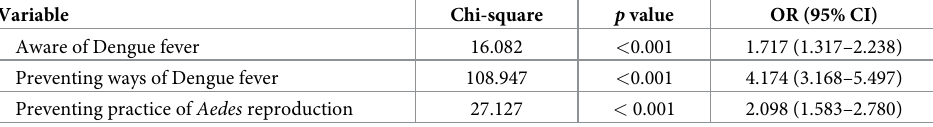
Table 6. Association between aware (Q-21), preventing ways (Q-33) and preventing practice (Q-35), and knowl- edge of dengue